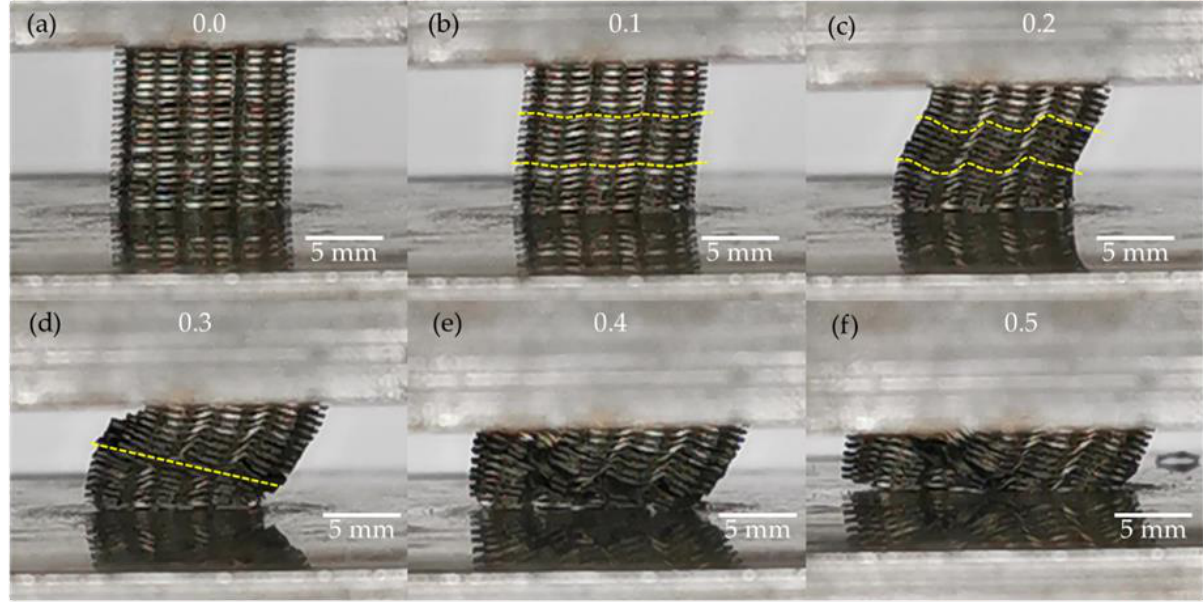
Figure 13. Compression test of the fifth sample at different strains ( a ) ε = 0, ( b ) ε = 0.1, ( c ) ε = 0.2, ( d ) ε = 0.3, ( e ) ε = 0.4, and ( f ) ε = 0.5.